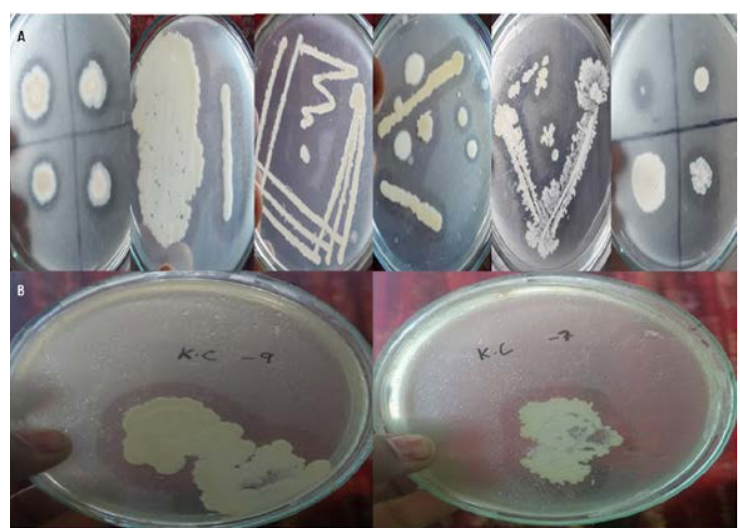
Fig.1. Screening of lipase positive bacteria using the Tributyrin agar (TBA)